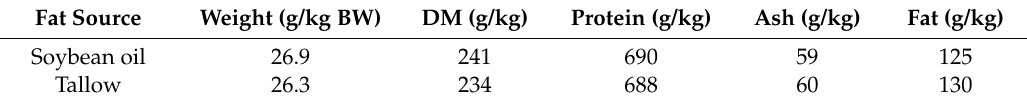
Table 1. Liver weight and proximate analysis of liver in broiler chickens fed maize-based diets (d 21) 1. Fat Source Weight (g/kg BW) Fat Source Soybean oil 26.9 Tallow 1 Each value represents the mean of 12